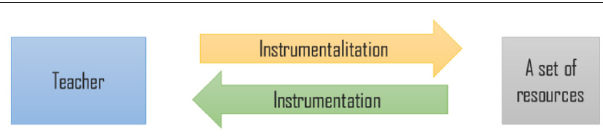
FIGURE 2 | Instrumental